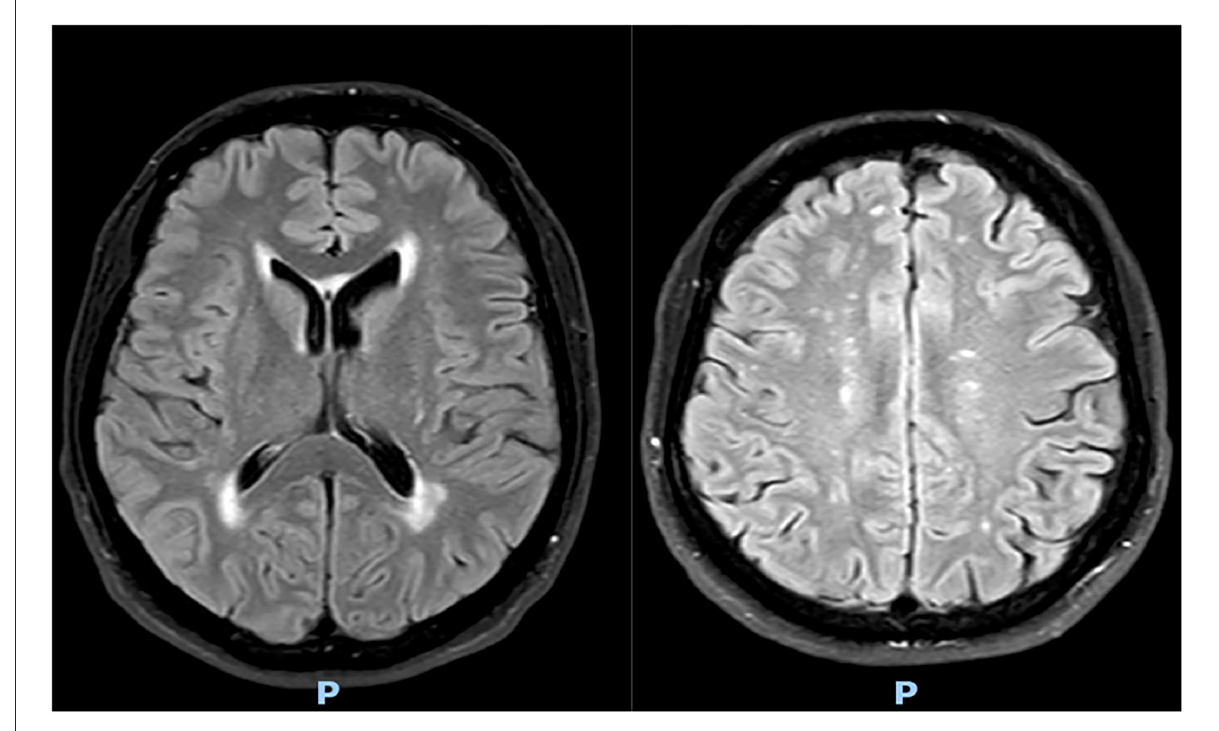
FIGURE1 Brain MRI showed multiple bilateral subcortical white matter